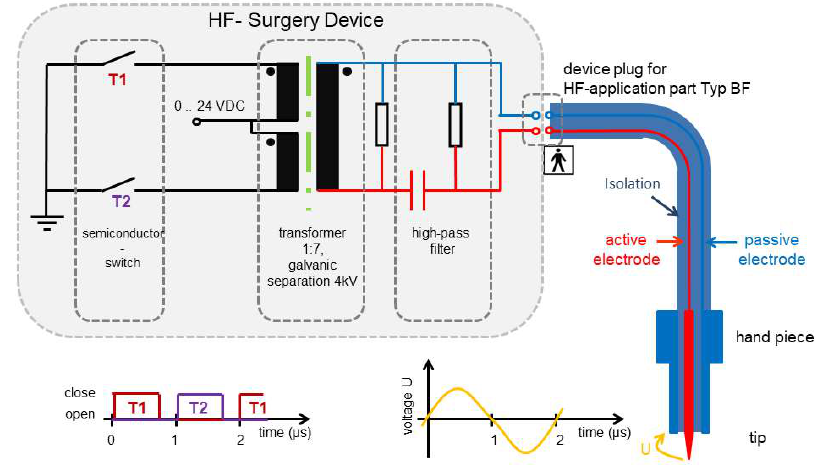
Figure 2. High-frequency (HF) generator.